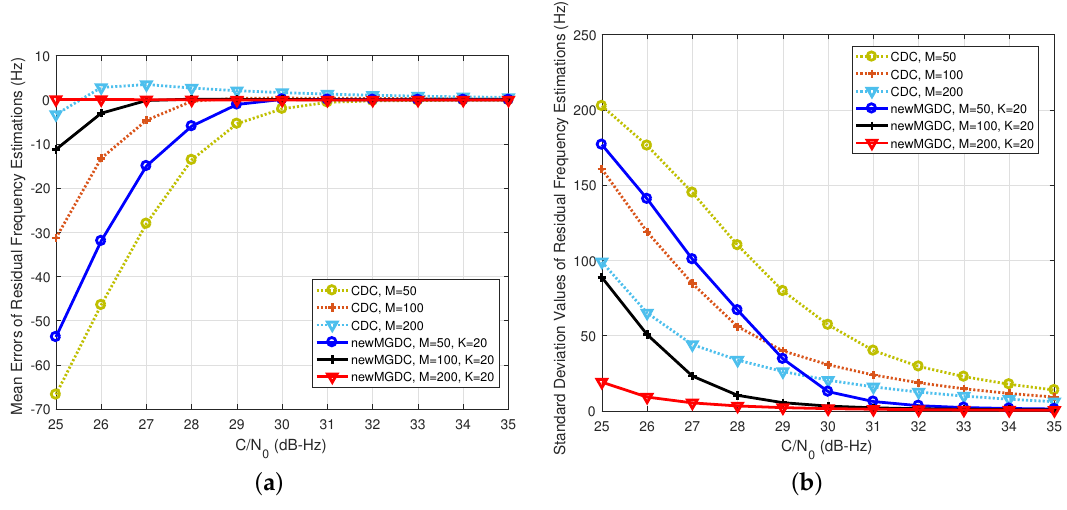
= 250 Hz, T = 1 ms). coh d